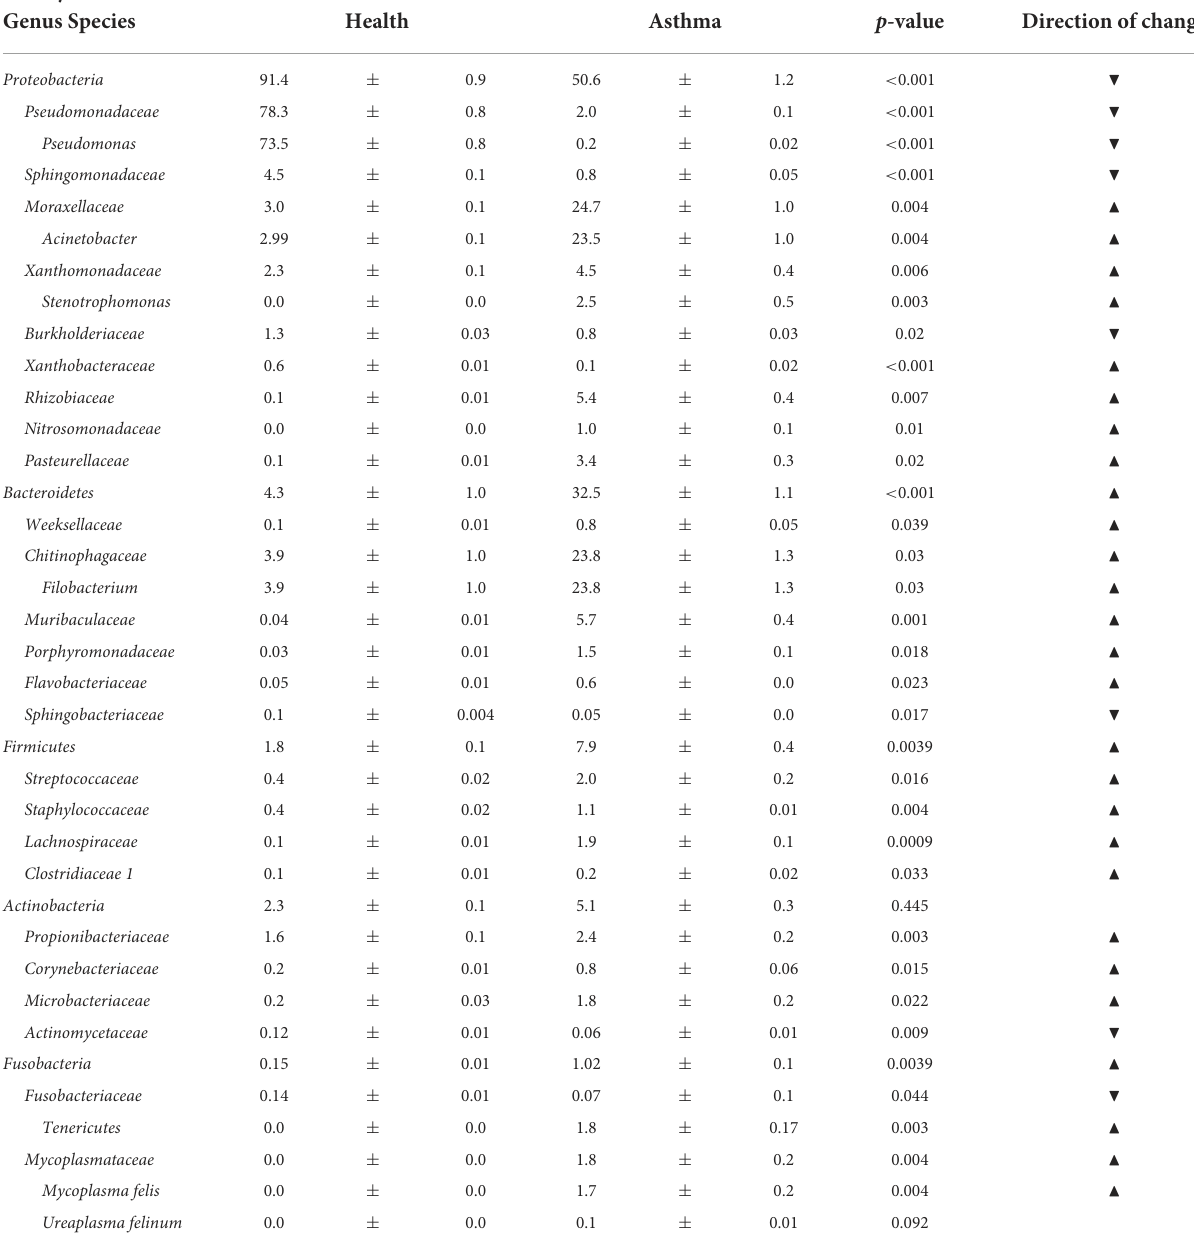
TABLE 1 Relative abundance (mean ± SEM%) of taxa present in any BALF sample at a minimum of 0.5% in either health or asthma that underwent at least a 2-fold and significant change ( p < 0.05) when comparing healthy and asthmatic cats or comprised more than 40% relative abundance in any